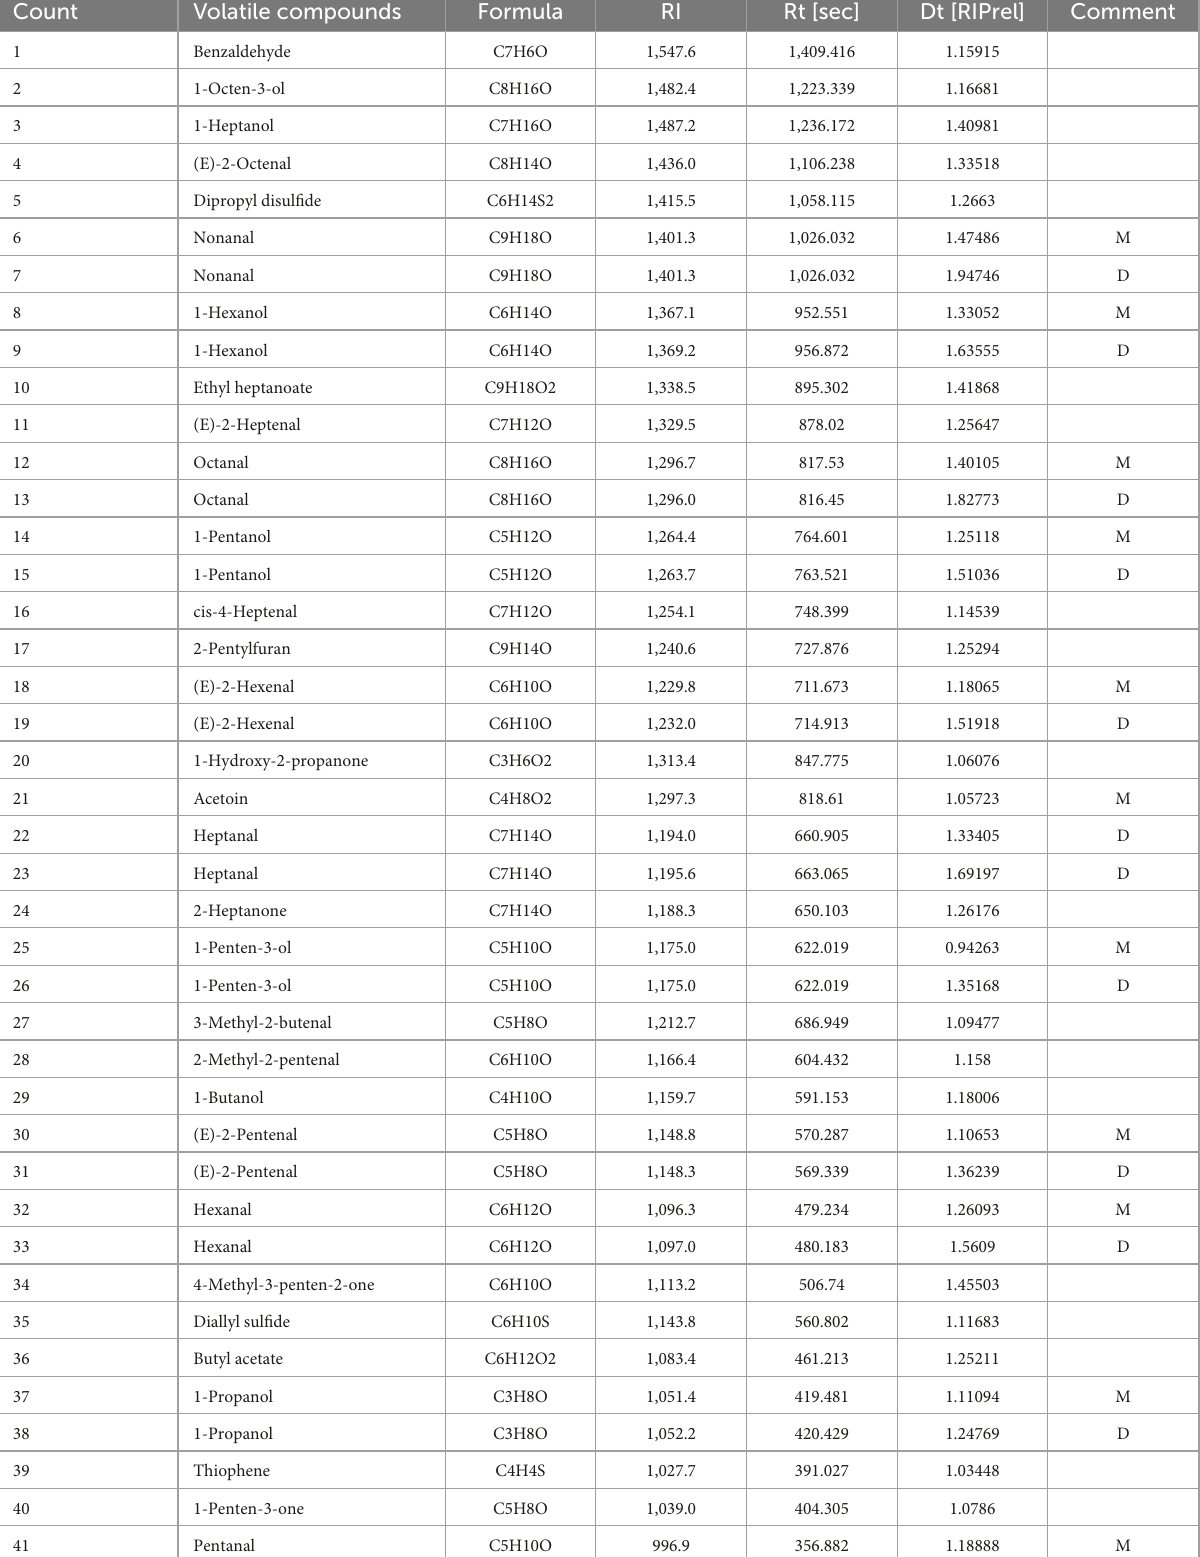
TABLE 3 Comparisons of the identified volatile compounds in surimi gels by gaschromatography-ion mobility spectrometry